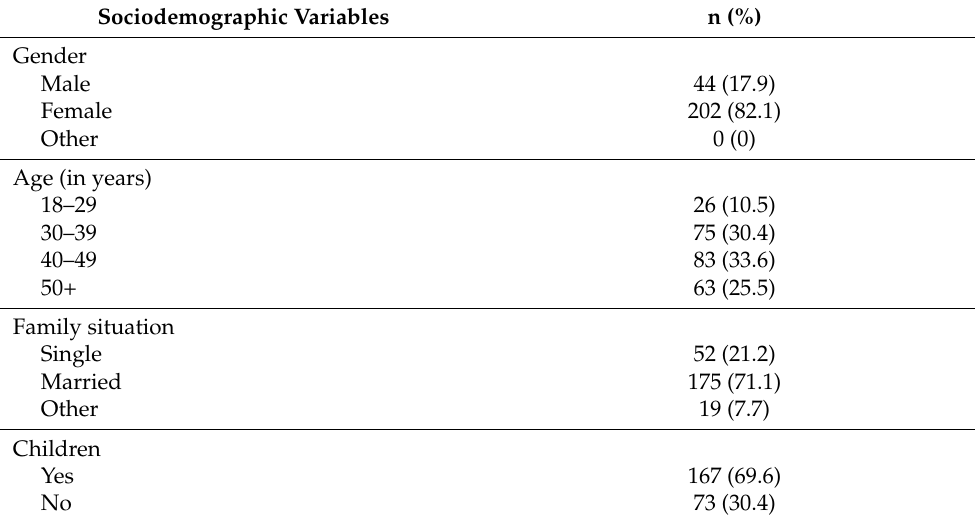
Table 1. Sociodemographic